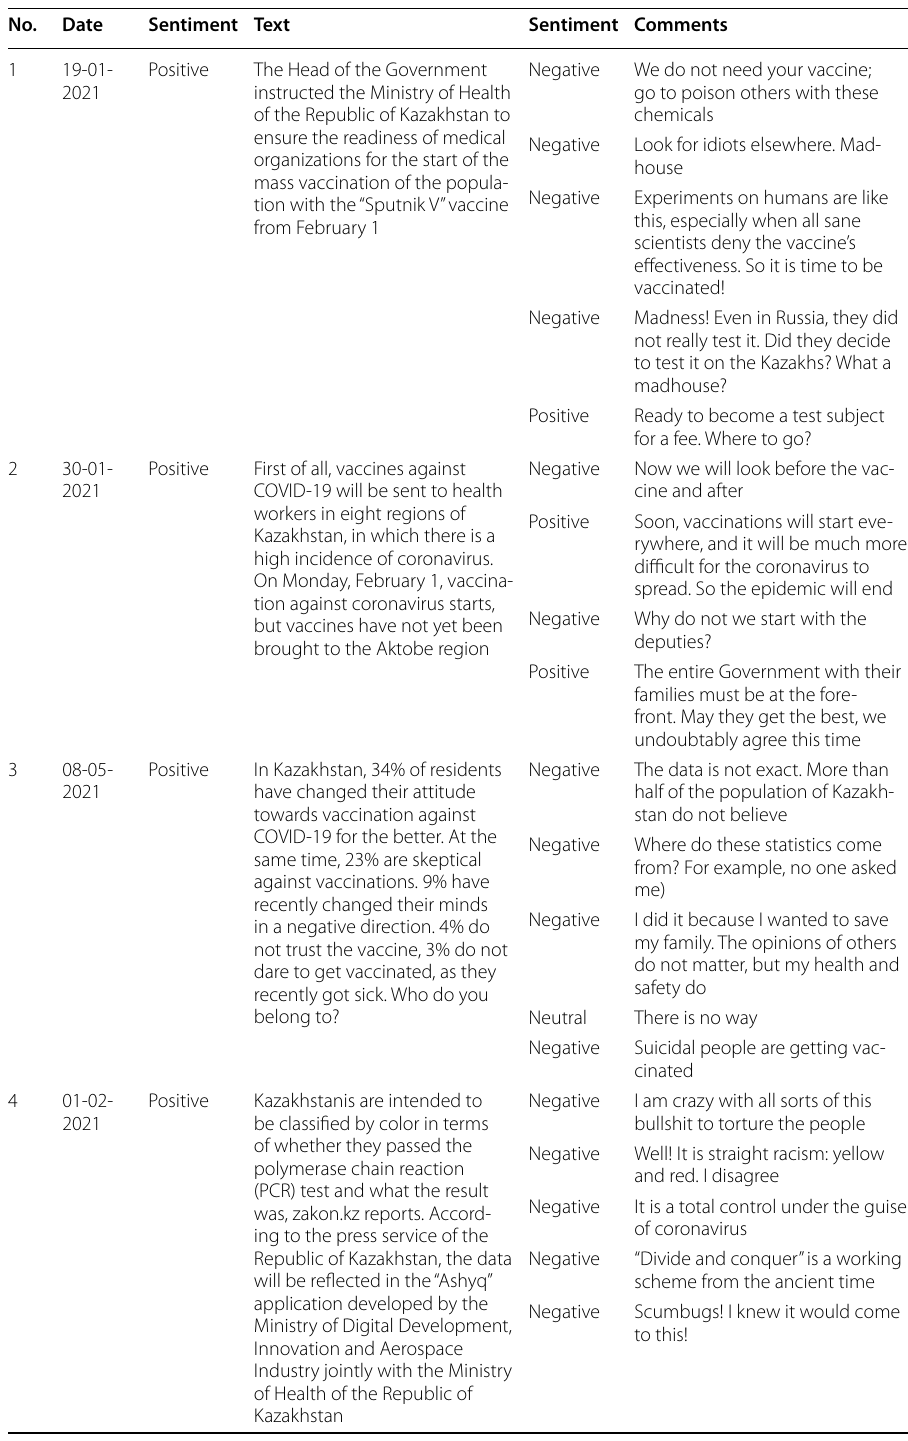
Table 13 Texts and comments for period 1